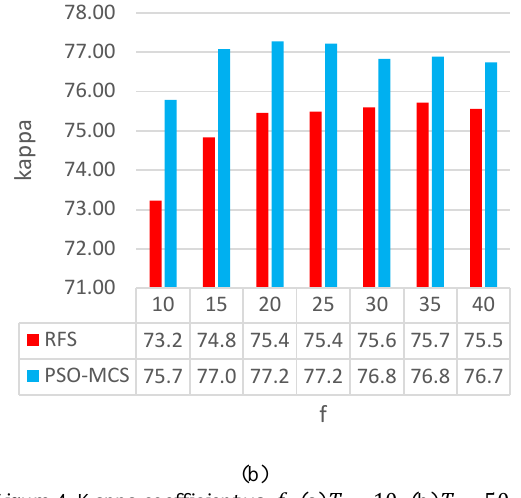
Figure 4. Kappa coefficient vs.